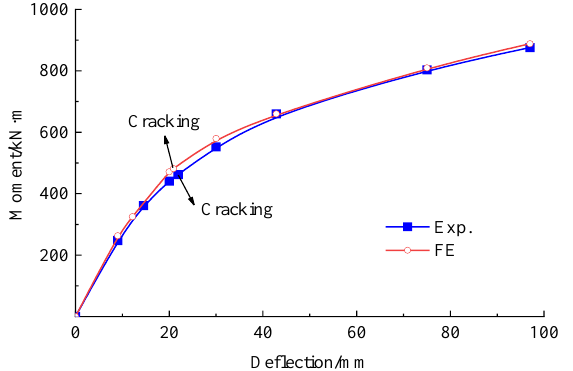
Figure 17. Bending moment vs. mid-span deflection curve of the strengthened beam. The mid-span deflection of the strengthened beam under the load P 0 was 42.8 mm, which decreased by 20.6% in comparison with that of the repaired beam. This demon- strates that the prestressed CFRP plates effectively improve the stiffness of the strength- ened beam, thereby improve the bearing capacity.